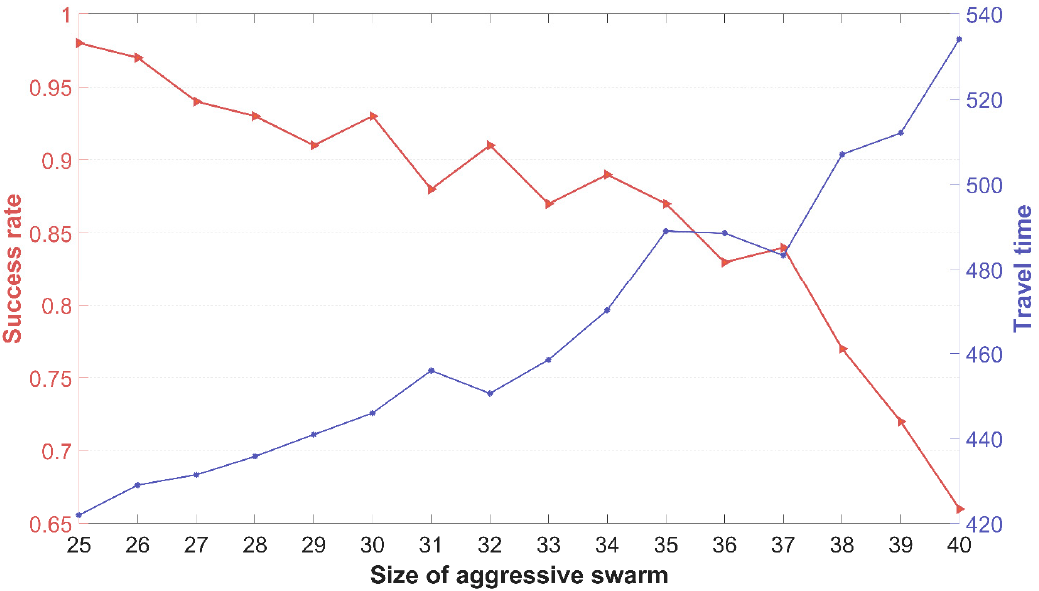
Figure 10. Escort effectiveness in response to swarm attacks with different attack sizes under real- world settings (50 escort individuals).